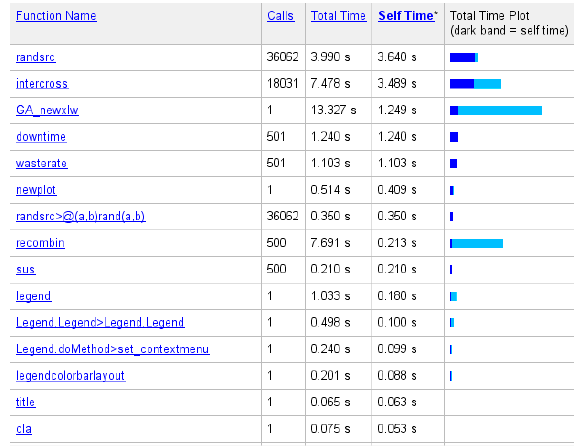
Figure 6. Running time graph.